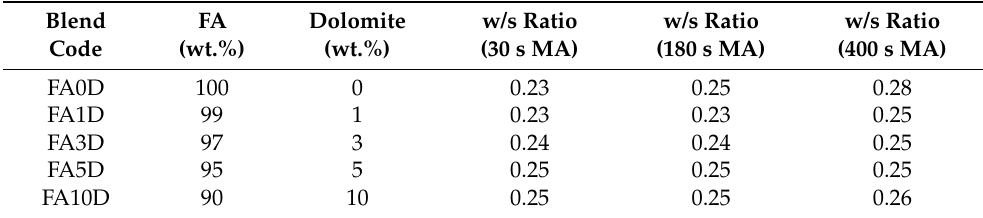
Table 2. Composition of blends used for preparation of